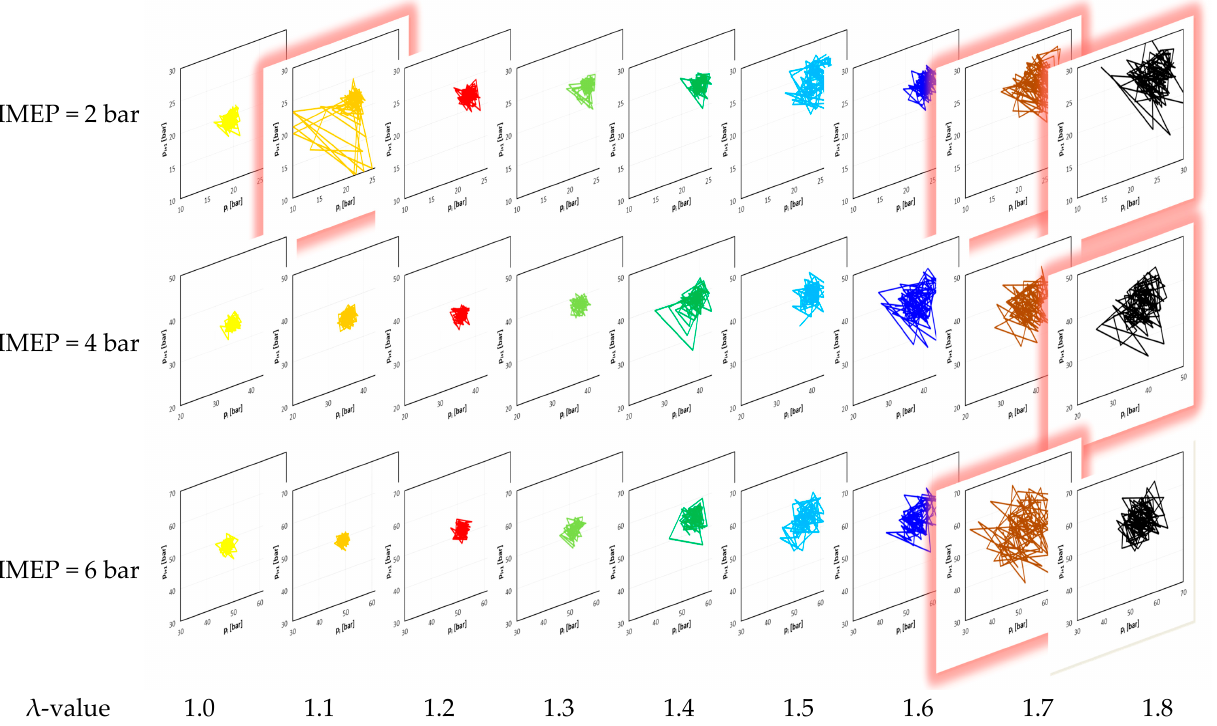
Figure 13. Analysis of work cycles in return map format for various engine load values for n = 1500 rpm.